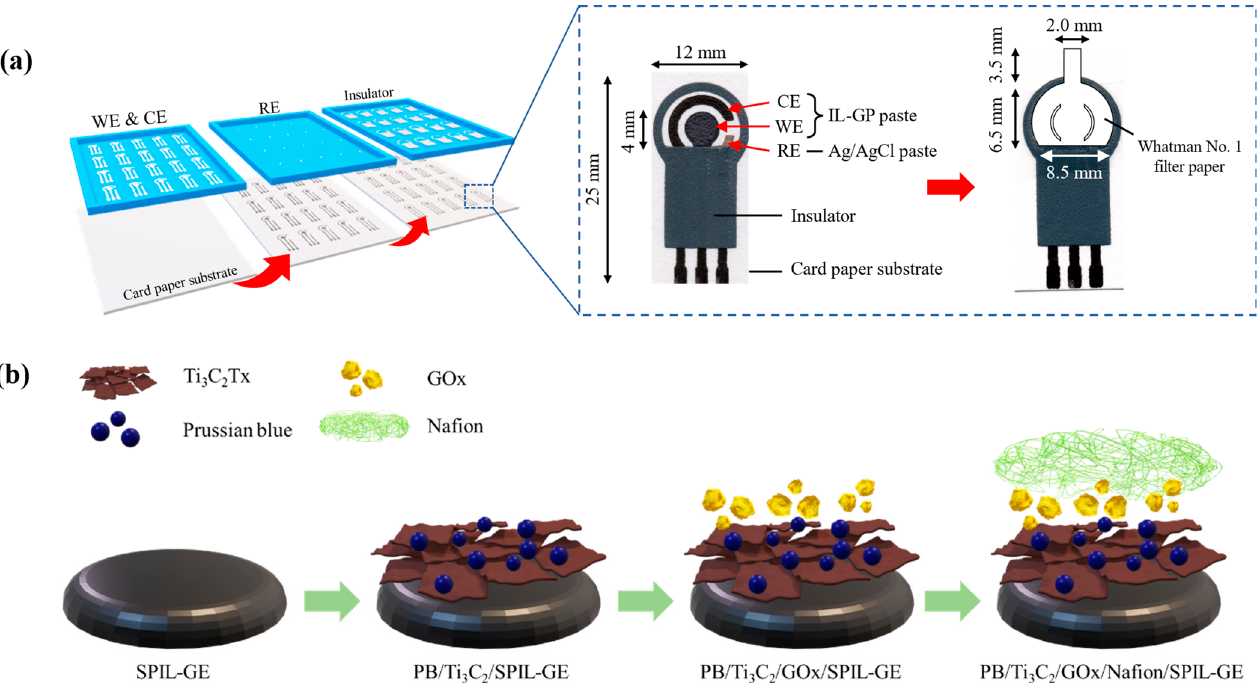
Figure 1. The fabrication process of paper-based SPIL-GEs glucose sensor. ( a ) fabrication steps of SPIL-GEs on paper based using IL-GP paste as WE and CE, Ag/AgCl paste as RE, and insulator paste, respectively; inset, details of each SPIL-GE (left); design and size of Whatman No.1 filter paper applied on the SPIL-GE (right), ( b ) modification steps of PB/Ti 3 C 2 T x /GOx/Nafion on paper-based SPIL-GE .